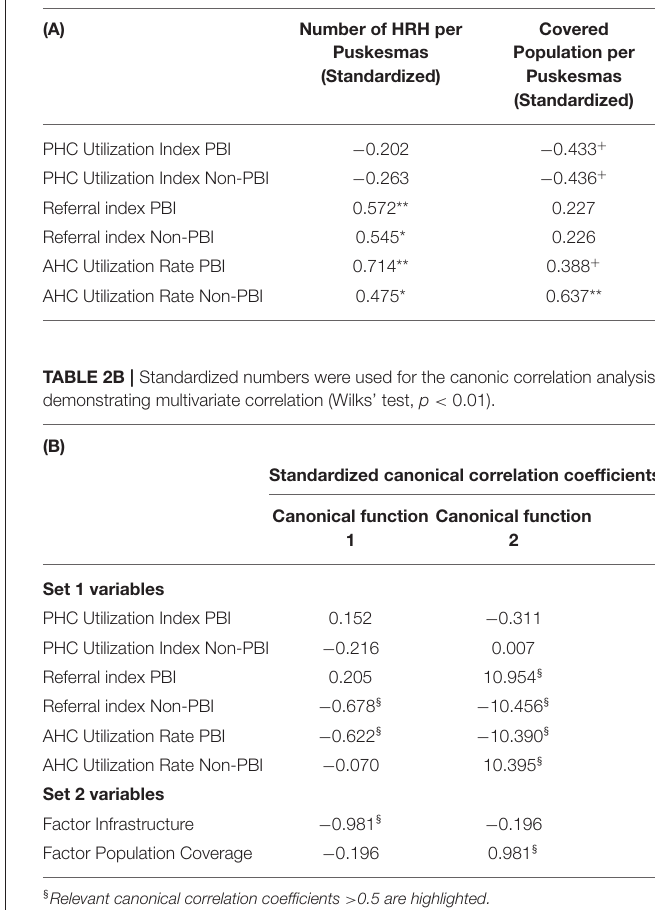
TABLE 2A | Pearson correlation between factors related to puskesmas and service indices ( + p < 0.05; * p < 0.005; ** p < 0.001).